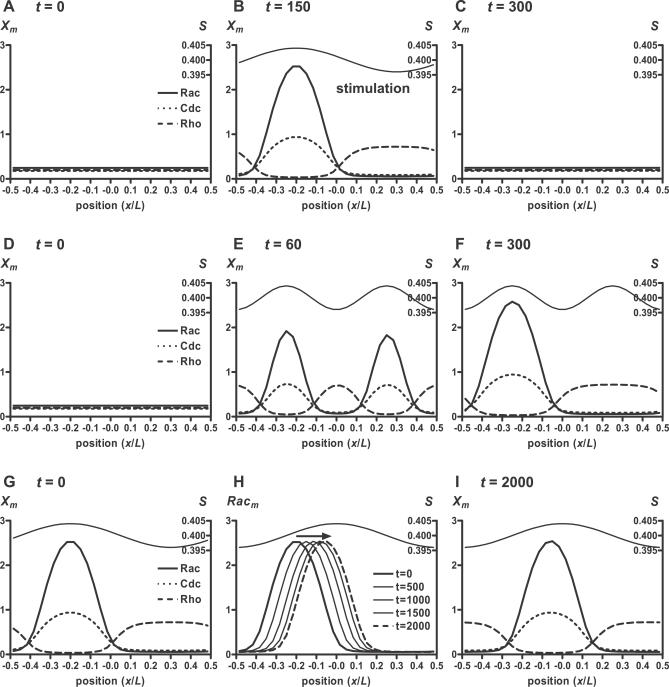
Behaviors of the Rho GTPases ModelSpatial profiles of Rac (solid lines), Cdc42 (dotted lines), and RhoA (dashed lines) are shown in (A–G) and (I). The thin lines in (B) and (E–I) indicate the spatial profile of the stimulation.(A–C) Reversible accumulation of the Rho GTPases. We set S = 0.1 at t = −100, and ran the simulation until t = 0 to reach the stationary state (A). Then, the stimulation S = 0.4{1 + 0.01cos[2π(x/L + 0.2)]} was given and the simulation was run until t = 150 to reach the stationary state (B). The stimulation point with the maximal intensity was at x/L = −0.2. The stimulation was reduced to the basal level (S = 0.1) again, and the simulation was run until t = 300 to reach the stationary state (C).(D–F) Multiple transient, and a single stable, accumulation peaks. Starting with the conditions in (A), we gave random perturbation (±0.01)) to obtain the homogenous initial conditions (D). Then, at t = 0, the stimulation S = 0.4{1 + 0.01 cos[2π(x/L + 0.25) × 2]} was given, and the simulation was run for the indicated time (E,F). The stimulation points with the maximal intensity were at x/L = −0.25 and 0.25.(G–I) Sensing of the stimulation gradient by the polarized peak. We set S = 0.4{1 + 0.01 cos[2π(x/L + 0.2)]} at t = −200, and the simulation was run to reach the stationary state where the polarized peak was seen at x/L = −0.2 (G). The new stimulation S = 0.4{1 + 0.01 cos[2π(x/L)]} was given, and the maximal intensity point was shifted to x/L = 0. The simulation was run for the indicated time (H,I). The arrow indicates the direction of movement of the polarized peak (H).